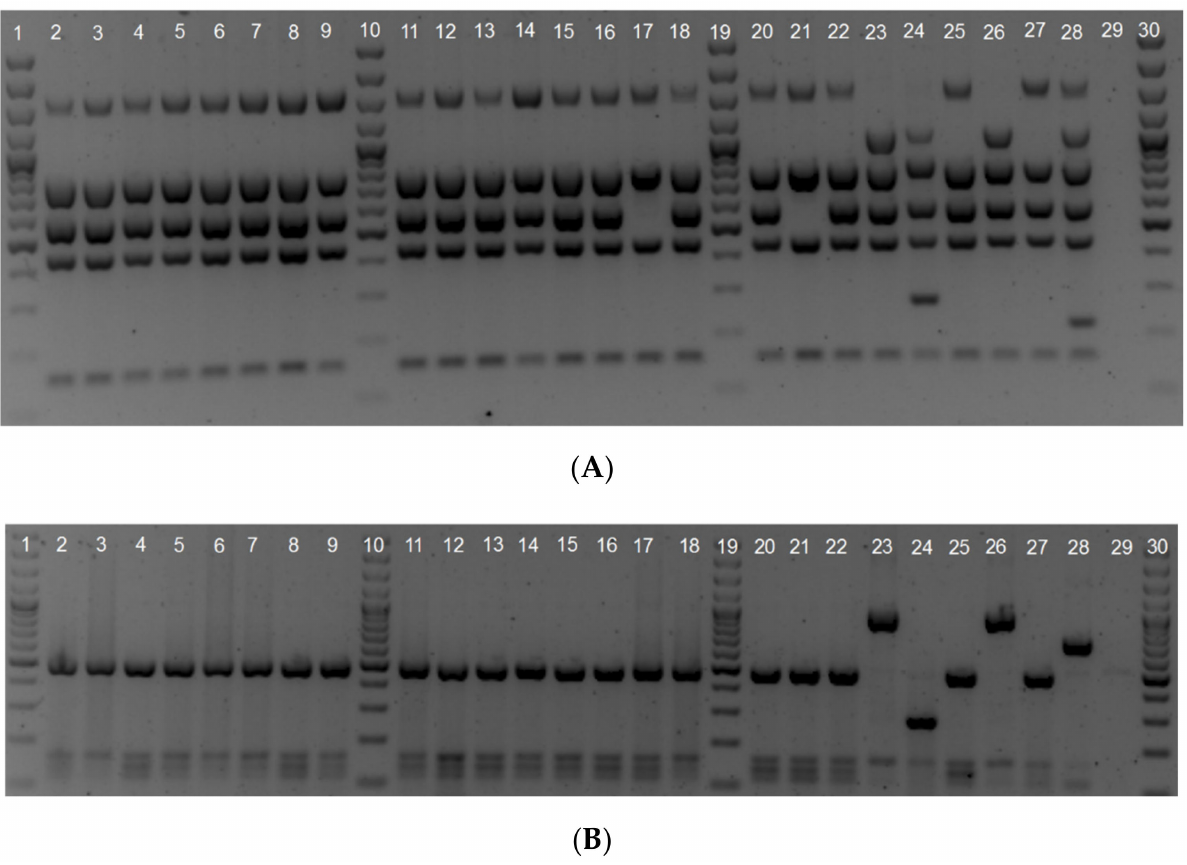
Figure 1. Gel images of Bruce-ladder ( A ) and AMOS ( B ) multiplex PCR assays. Descriptive information is given in Table S1. Table 1. A list indicating the old sample names, new assigned sample names, and accession numbers of South African Brucella abortus strains characterized in this